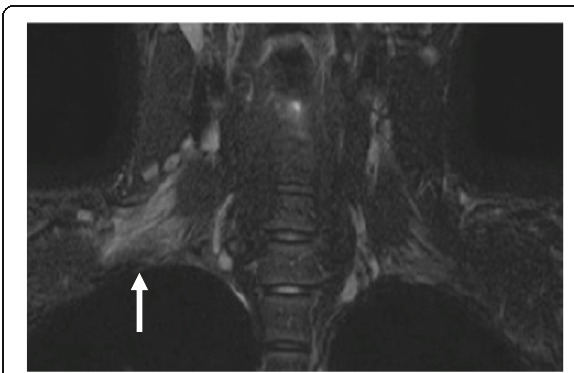
Fig. 1 Coronal T2-weighted MRI of the neck at 1 week after surgery showing diffuse nerve enlargement and increased homogeneous signal intensity of the right brachial plexus (arrow). MRI indicates magnetic resonance